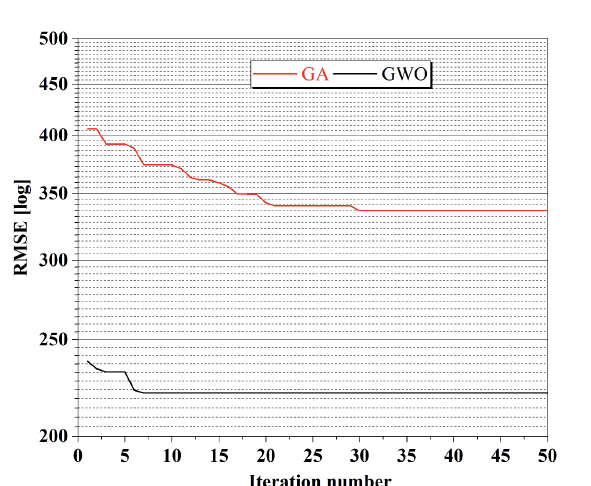
Fig. 9. Error histogram